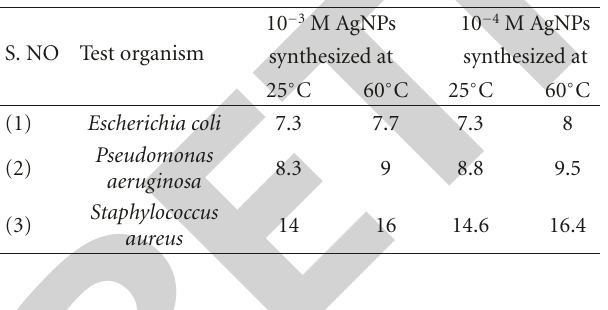
Table 1: Zone of inhibition (mm) of biologically synthesized silver nanoparticles against bacterial